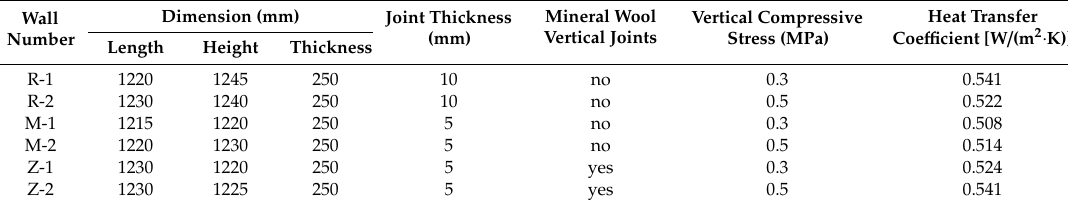
Table 1. Details of the specimens.